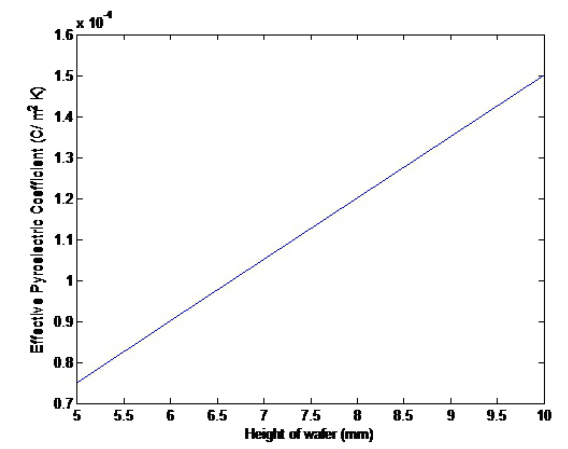
Figure 9: Plot of the effective ⟨ τ 1 ⟩ pyroelectric coeflcient vs. height of the piezoelectric